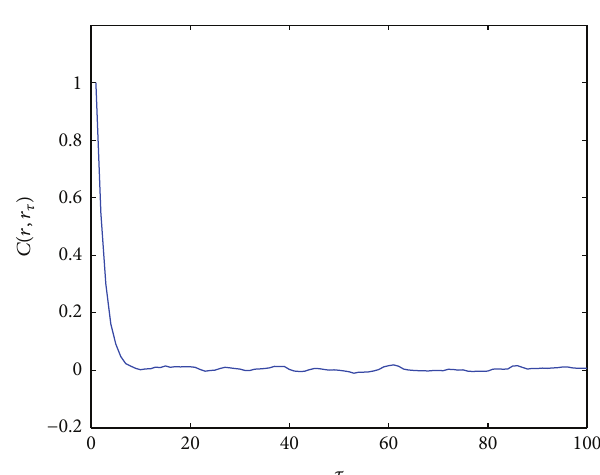
Figure 8: Autocorrelation function of the log return of the realiza- tion shown in Figure